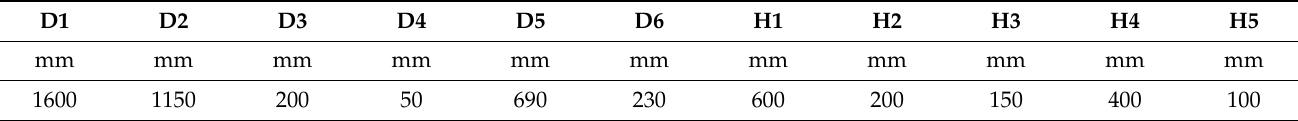
Table 1. Parameters of airlift